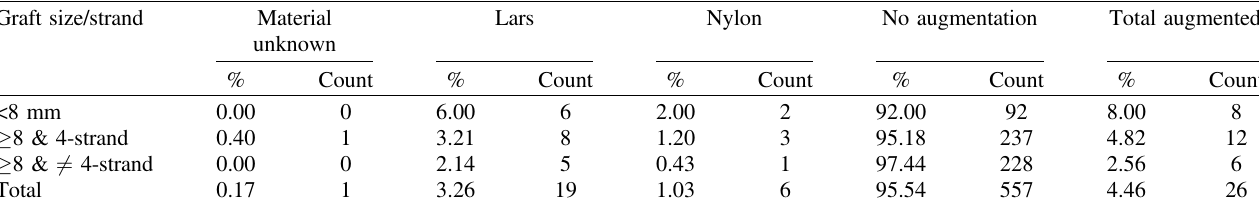
Table 2. Percentages and Counts for different types of augmentation in different groups of graft size/strand. Graft size/strand